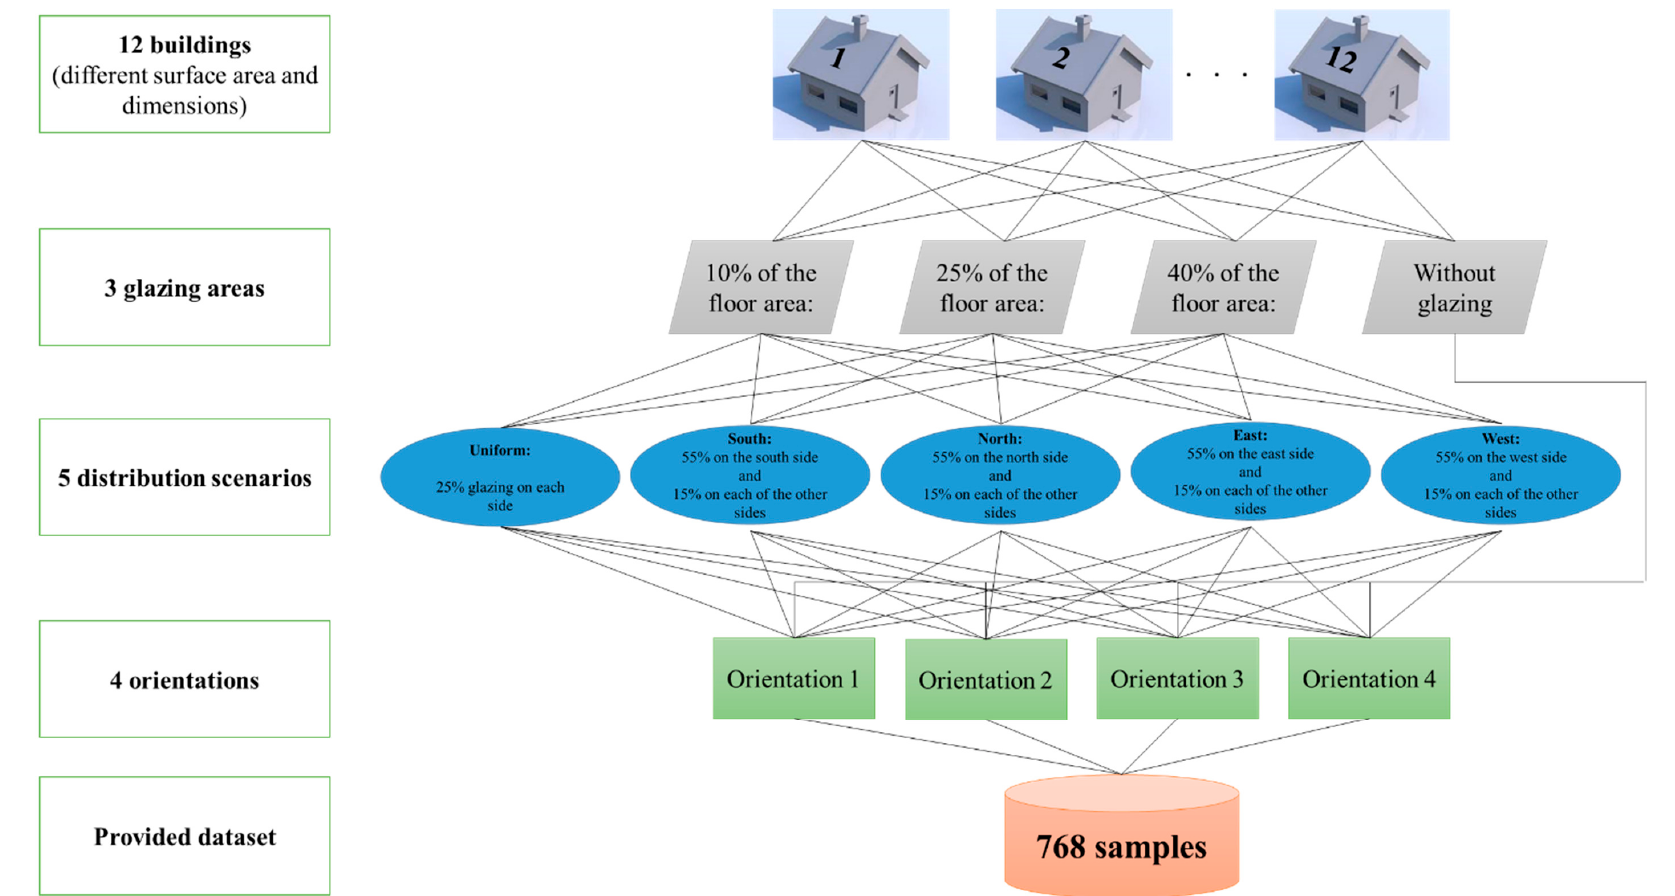
Figure 4. Graphical view of data preparation.